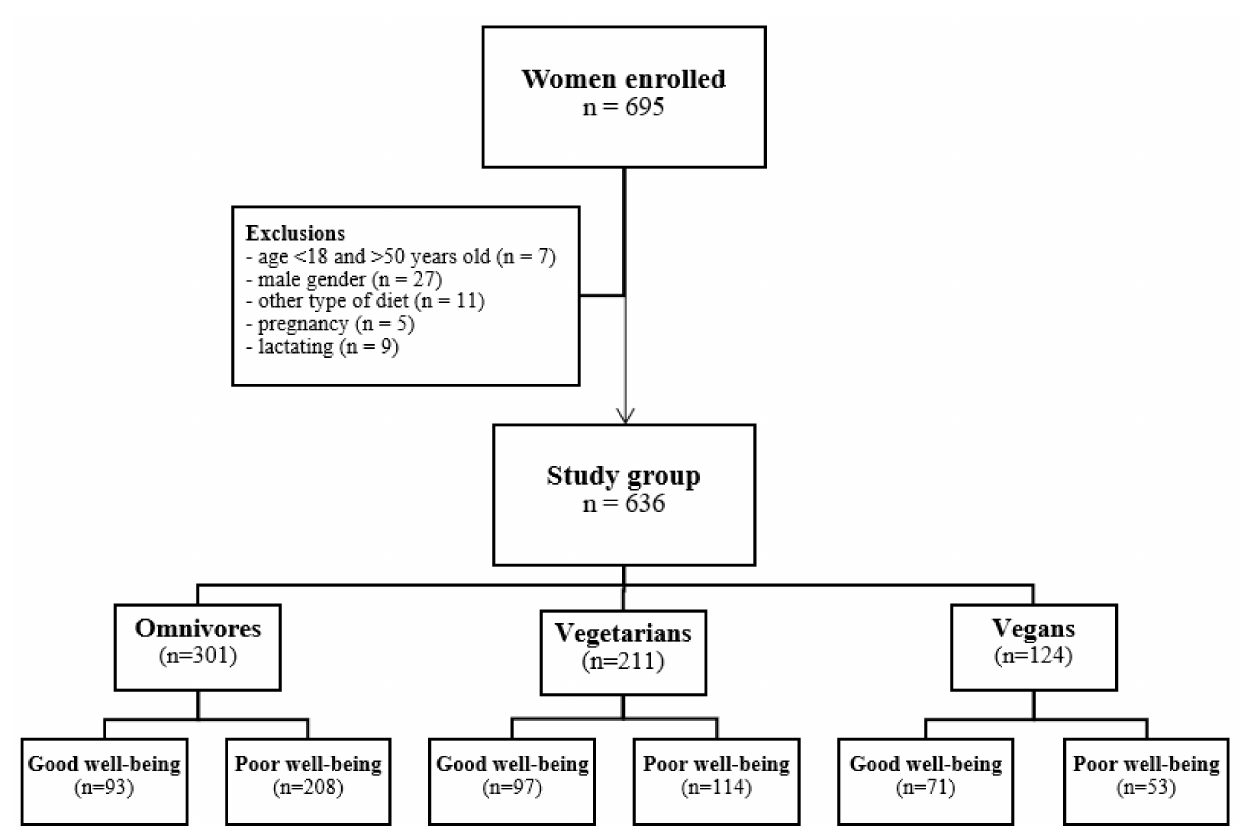
Figure 1. The detailed sampling procedure and recruitment of the studied